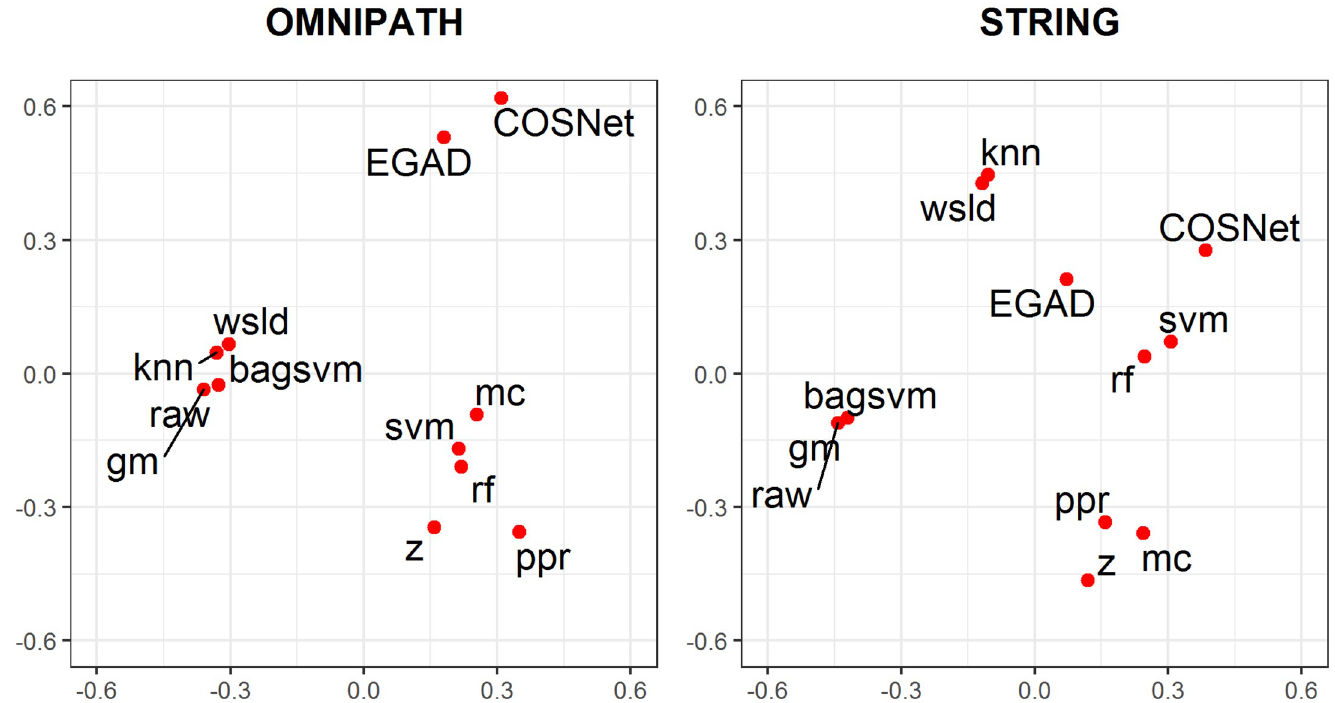
Fig 6. Multi-view MDS plot displaying the preserved Spearman’s footrule distances between methods. The differential ranking of their top 100 novel predictions using known drug target inputs are taken into account across all 22 diseases. Results are shown separately for the 2 networks considered in this study. Seed genes are excluded from the distance